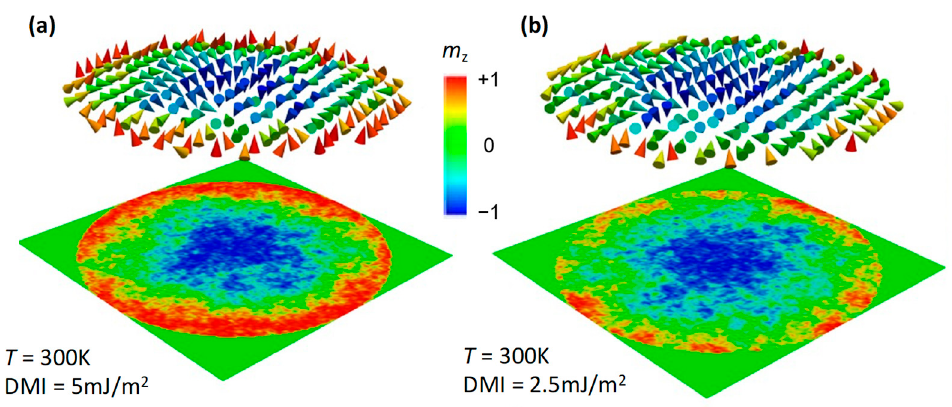
Figure A2. Skyrmionic state at different temperatures: ( a ) T = 0 K, ( b ) T = 100 K, ( c ) T = 300 K. The calculation has been performed for a 90 nm disk with the following parameters: DMI = 5 mJ/m 2 , K u = 1.7 × 10 +6 J/m 3 , M s = 1714 kA/m, A ex = 2.1 × 10 +11 J/m; the Gilbert damping constant α = 0.01. In each panel, the top image is a glyph representation of the magnetization vector field within the disk. The bottom image is a scalar field representation of the m z values.